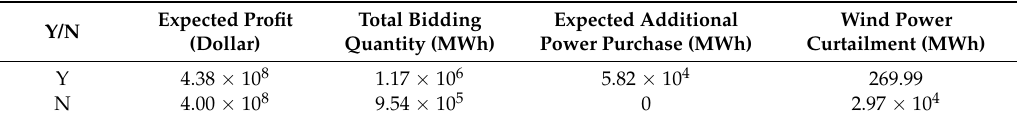
Table 2. The effect of additional electricity on decision-makings.